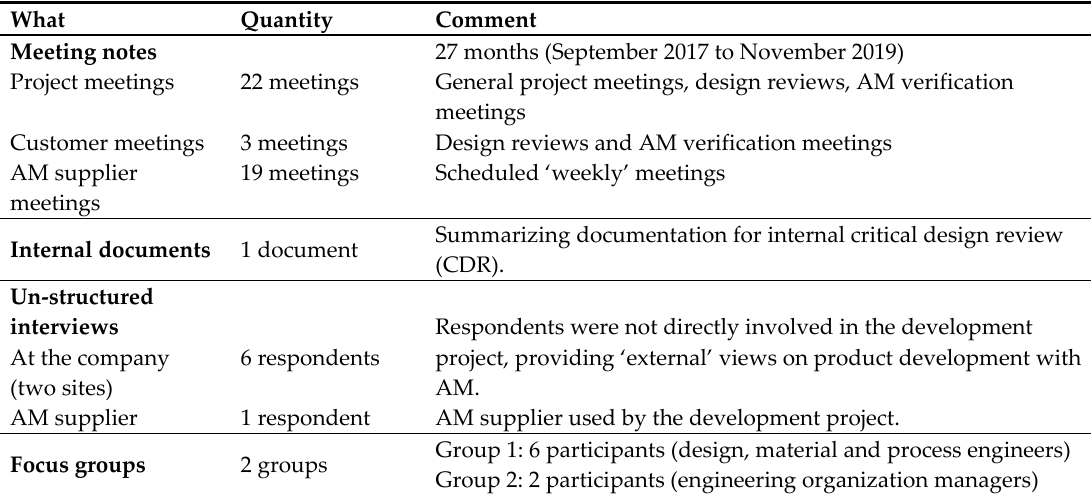
Table 1. Data collection during the research process.